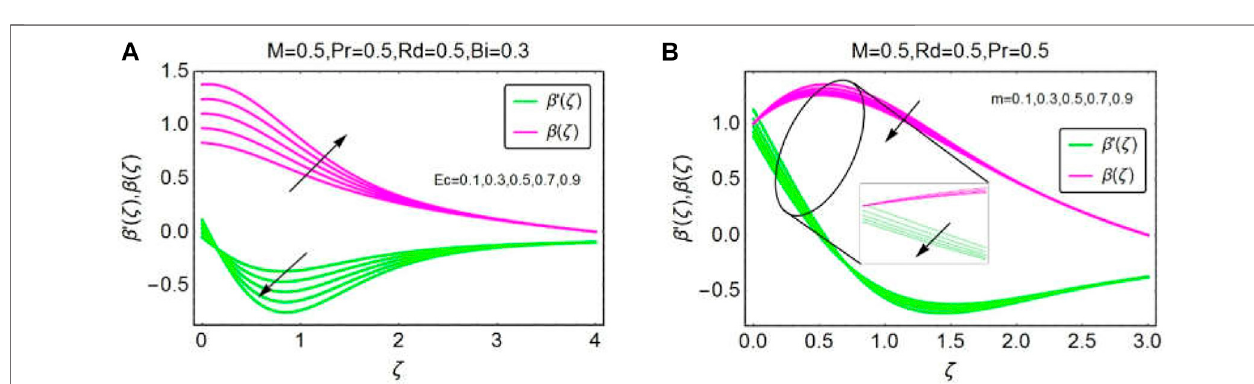
FIGURE 4 | In fl uence of (A) Ec and (B) m on β ( ζ ) and β ′ ( ζ ) .